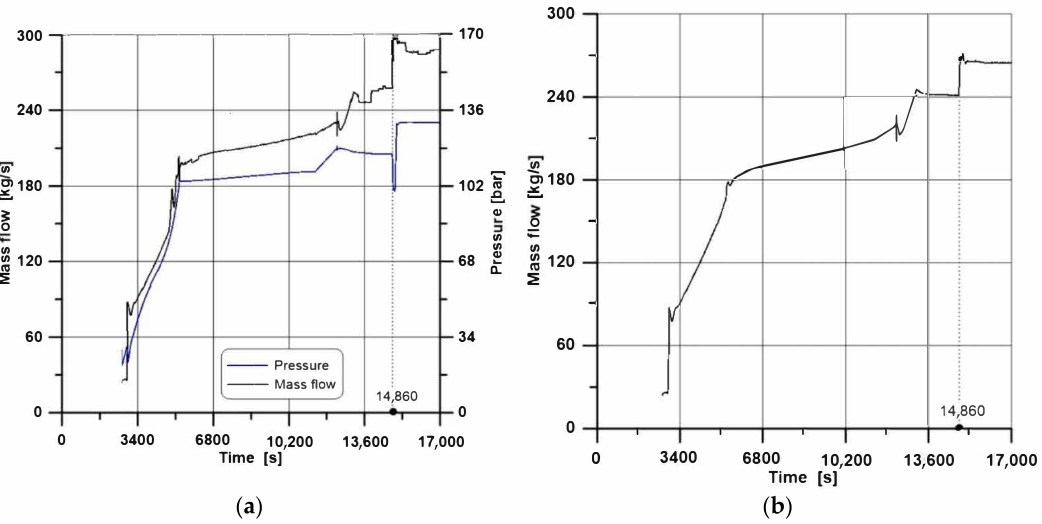
Figure 6. ( a ) Changes in the mass flow rate of steam and pressure at the SH4 (SuperHeater) outlet (at the boiler outlet) in the entire time of operation; ( b ) The mass flow rate of steam at the evaporator outlet in the entire period of operation under analysis; Reprint with permission [70]; 2019, Elsevier. On the same lines, a dynamic plant operation optimization control system was simulated in